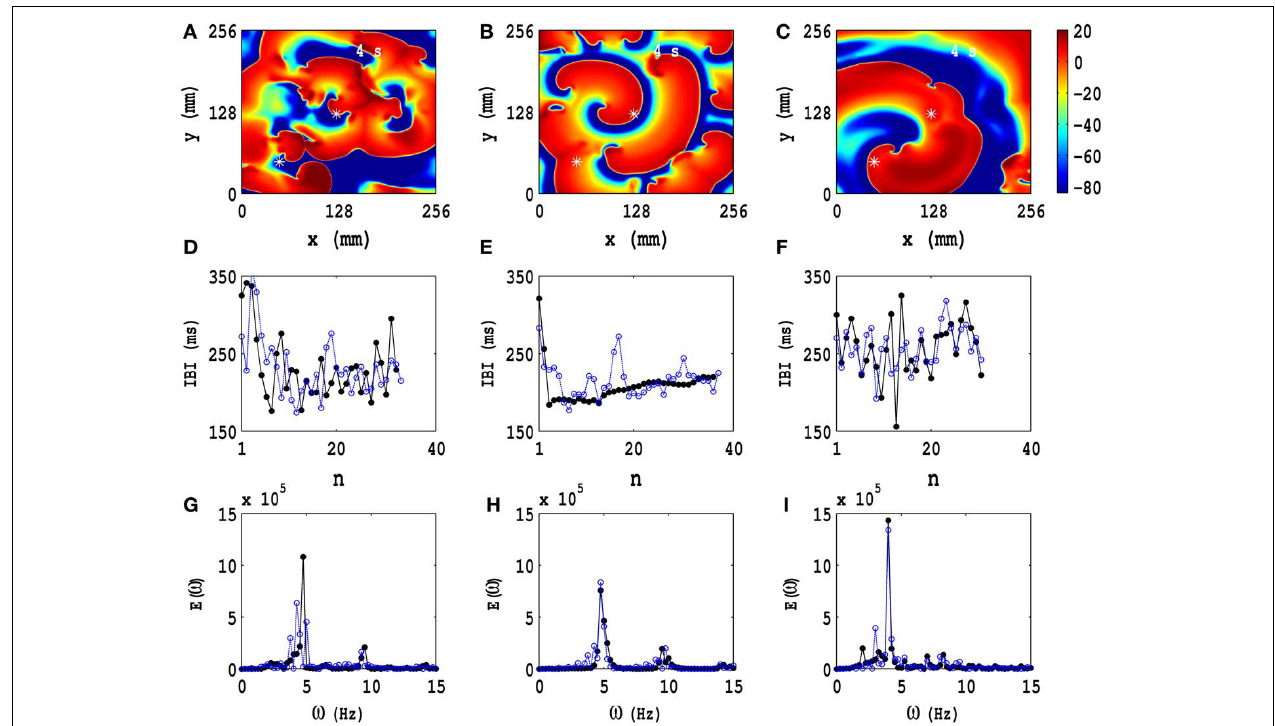
FIGURE 6 | Temporal evolution of representative ST states in the TP06 model with PD along both spatial directions. Three ST states, which we obtain with the initial condition IC 1 and PD, are shown via pseudocolor plots of thetransmembrane potential V m with (A) A x = A y = 0 . 3 , f x = f y = 3 . 0Hz, (B) A x = A y = 0 . 3 , f x = f y = 5 . 0Hz, and (C) A x = A y = 0 . 4 , f x = f y = 7 . 0Hz; the animations (b3), (c3), and (d4) in Video S3 show, respectively,